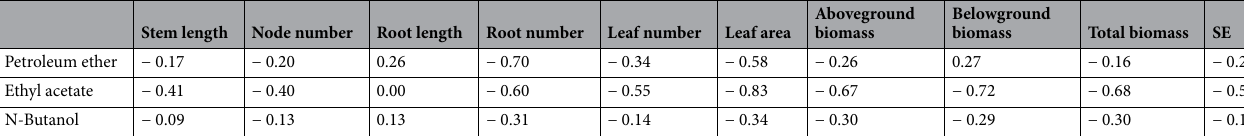
Table 3. The allelopathic effects of the extracts of H.scandens on